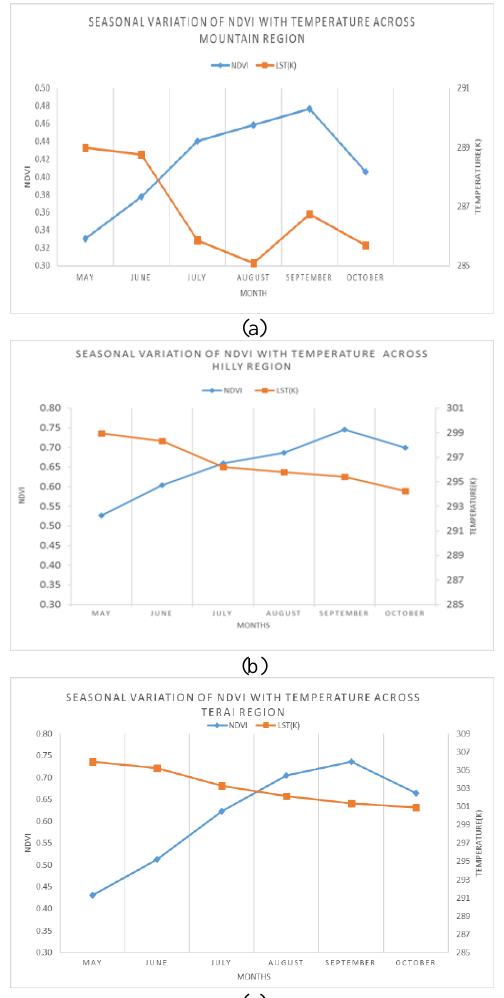
Figure 6 (a)-(c). Graph showing seasonal variation of NDVI with Temperature across (a).mountain, (b).hilly and (c). terai region The LST value is greatly affected by altitude. The maps and graphs (figure 6 and 7) together depicted the fact that, unlike precipitation, the temperature showcased inverse relationship with vegetation. The temperature was the highest amongst all, in May while the vegetation was likely to be the least. As the month progressed, the temperature showed decreasing trend while the NDVI values showed the exact opposite. But this trend continued until the temperature was high. By the time it was October, both NDVI and temperature showed downward trend suggesting that, NDVI stayed inversely proportional to high temperature but once the temperature values started decreasing, NDVI almost became immune to its effect.